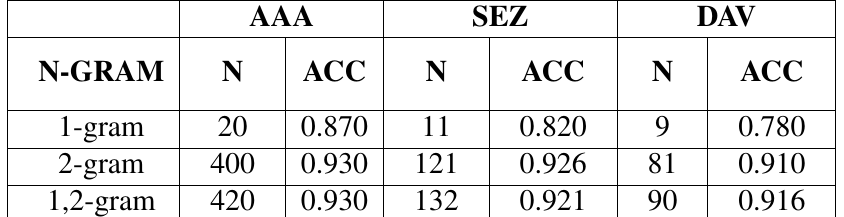
Table 2: N-gram classification results for the different alphabets without feature selection, where N is the size of a feature set and ACC stands for classification accuracy (ratio of correctly classified sequences to all